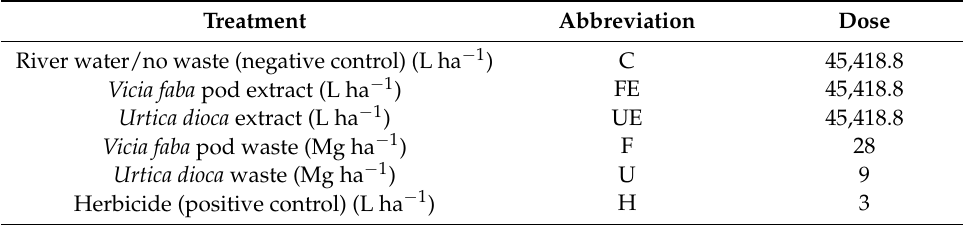
Table 1. Doses for treatments tested in Experiment 1.